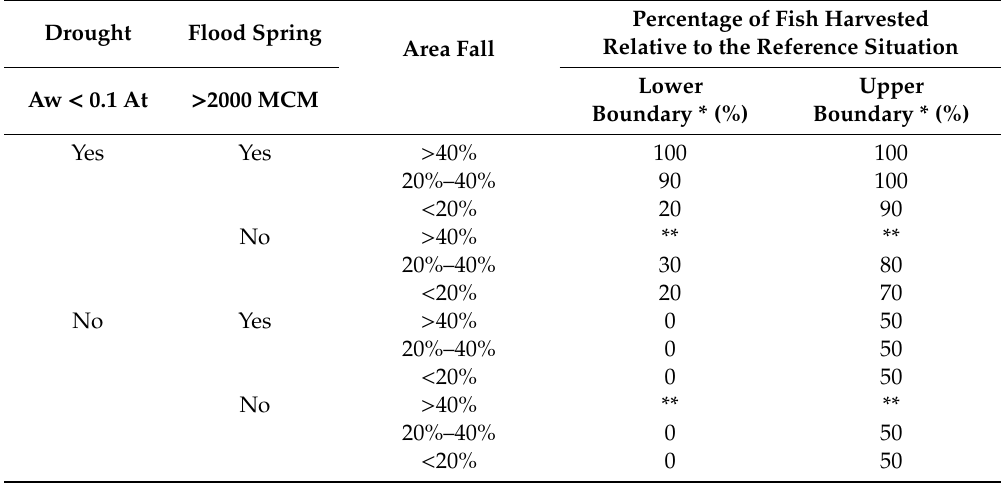
Table 1. Estimated e ff ects for combination of parameter values